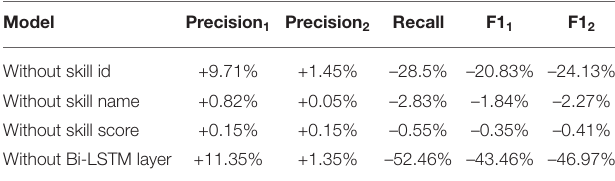
TABLE 5 | Experimental results of ablation